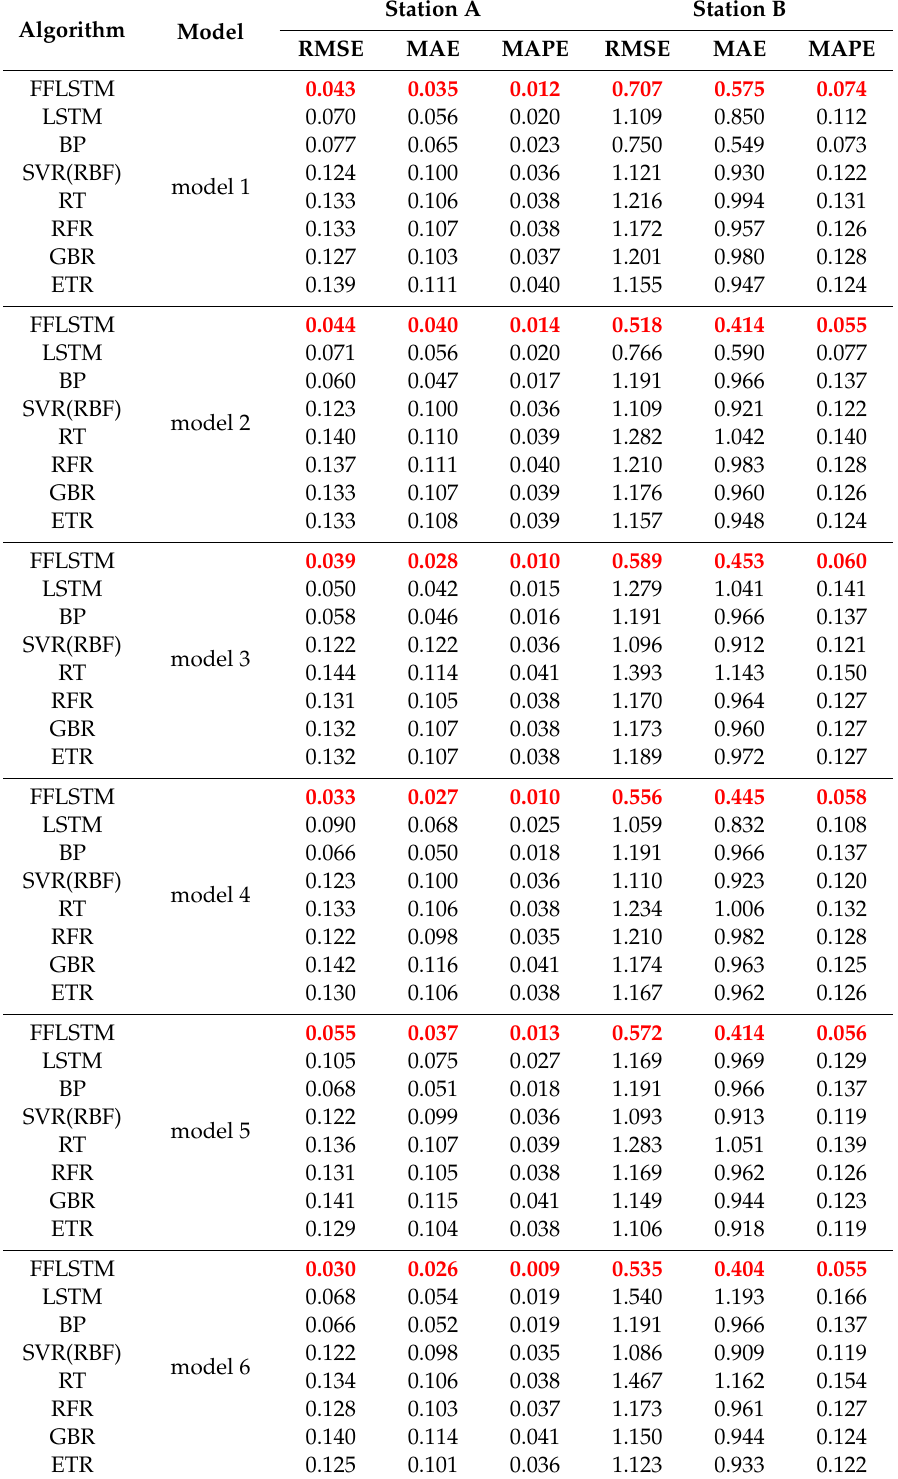
Table 8. The performance comparison of di ff erent algorithm for six